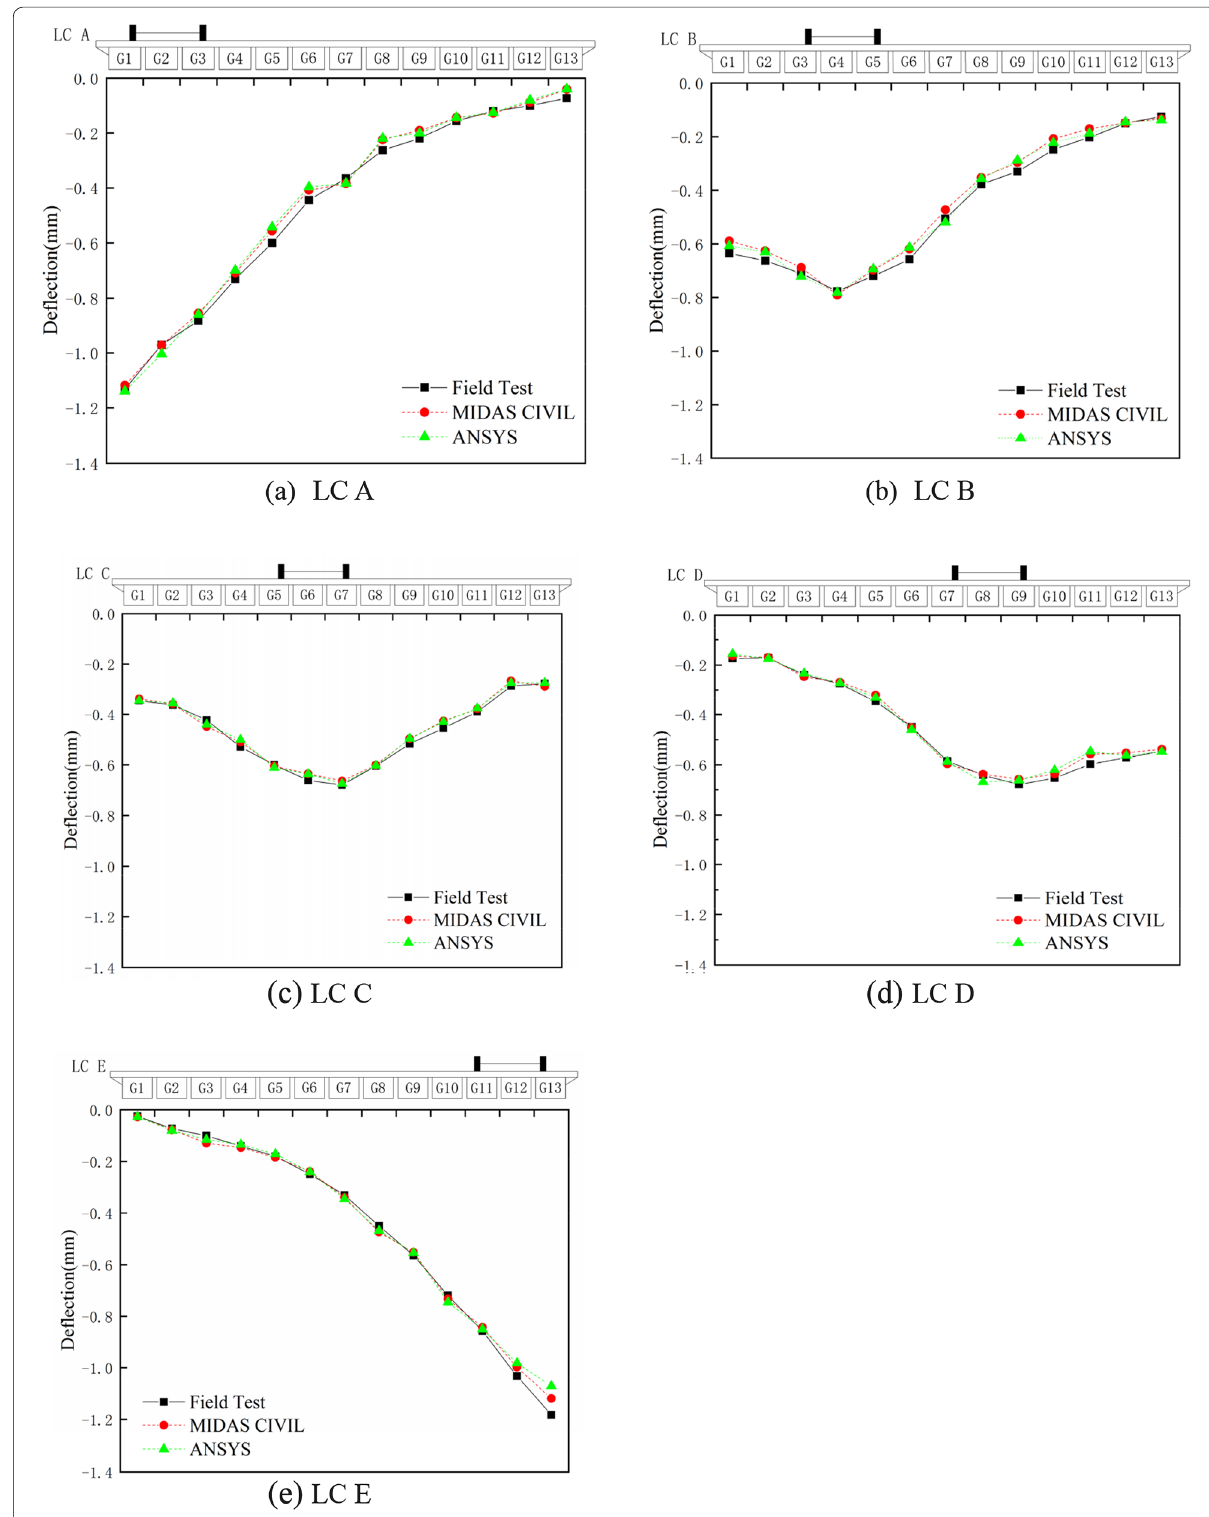
Fig. 13 Deflection distribution in different loading